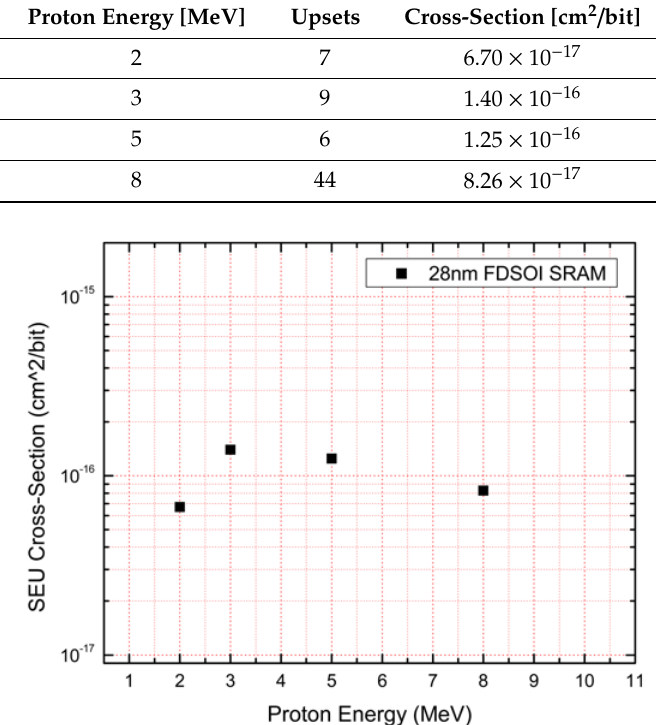
Figure 4. SEU cross-sections at each energy point.